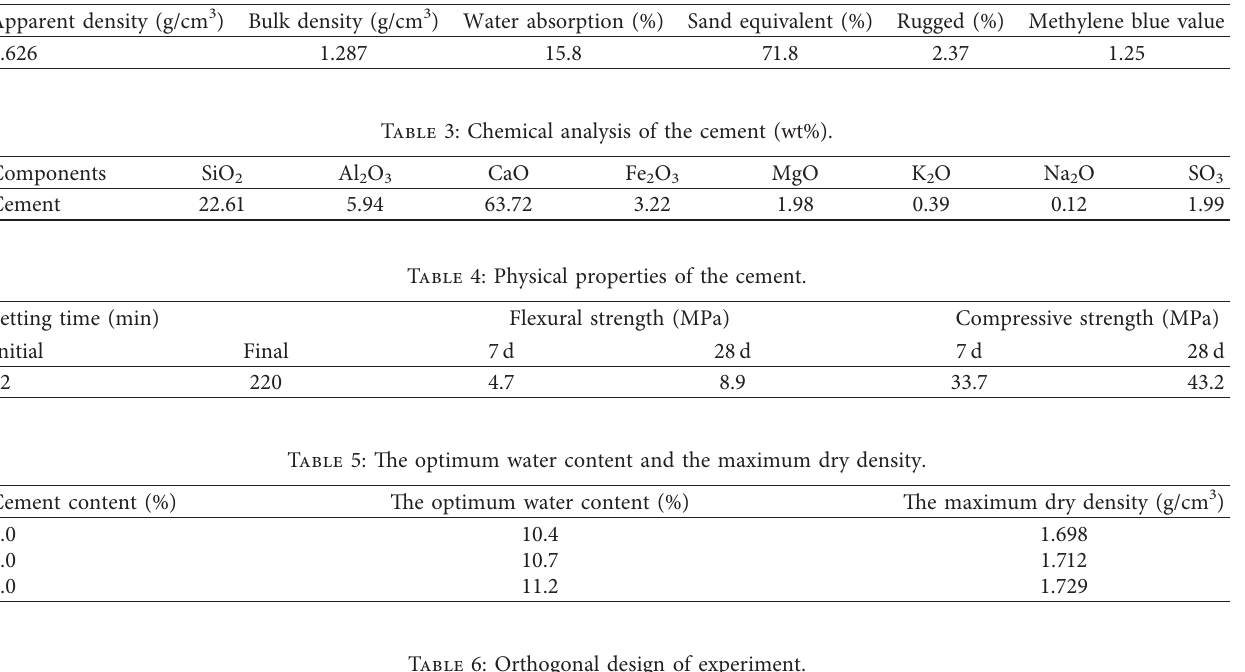
Table 2: Basic performance of coral sand.